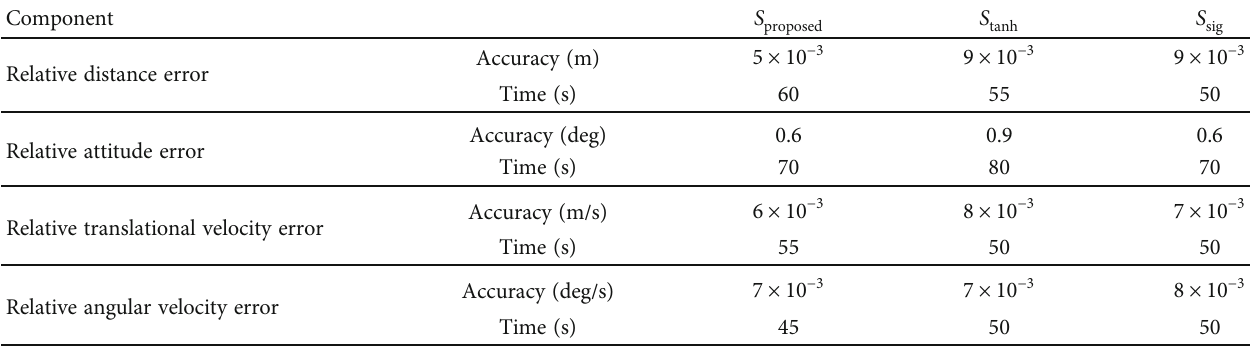
Table 6: Control precision